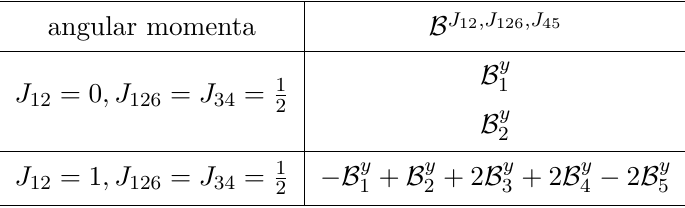
Table 6 . Partial-wave basis of partition M ( ψ 1 , ψ 2 | ψ †